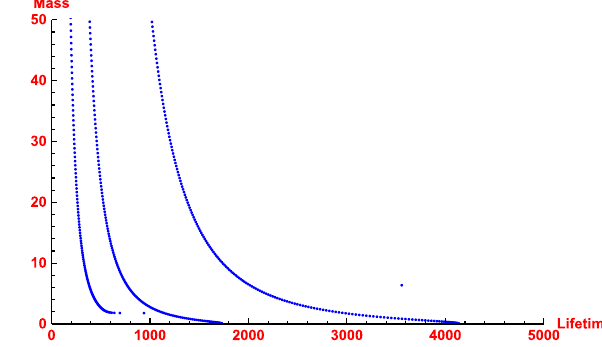
Fig. 2 The numerical results of BH mass M w.r.t lifetime t by setting y > 0 (corresponding to ζ > 0). We set y = 1 with l = 1, l = 1 . 5 and l = 2 from left to right